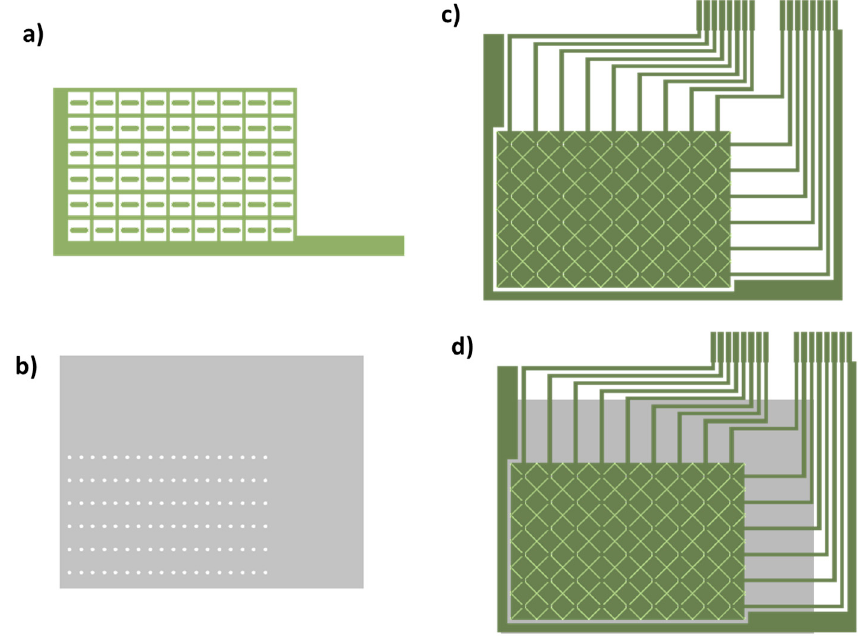
Figure 3. One Layer Design (OLD): ( a ) conductive layer for connection tracks; ( b ) dielectric layer with via-holes; ( c ) X-Y layer; and ( d ) the complete design.